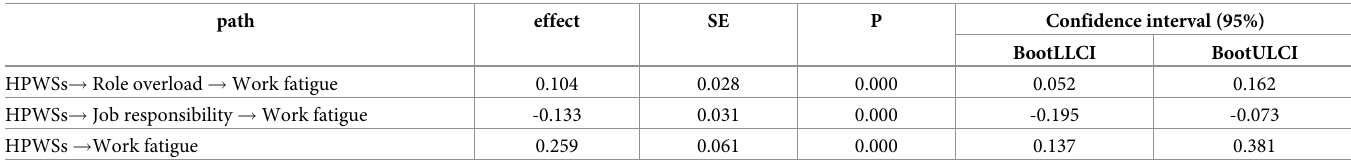
Table 3. Mediating effect test of role overload and job